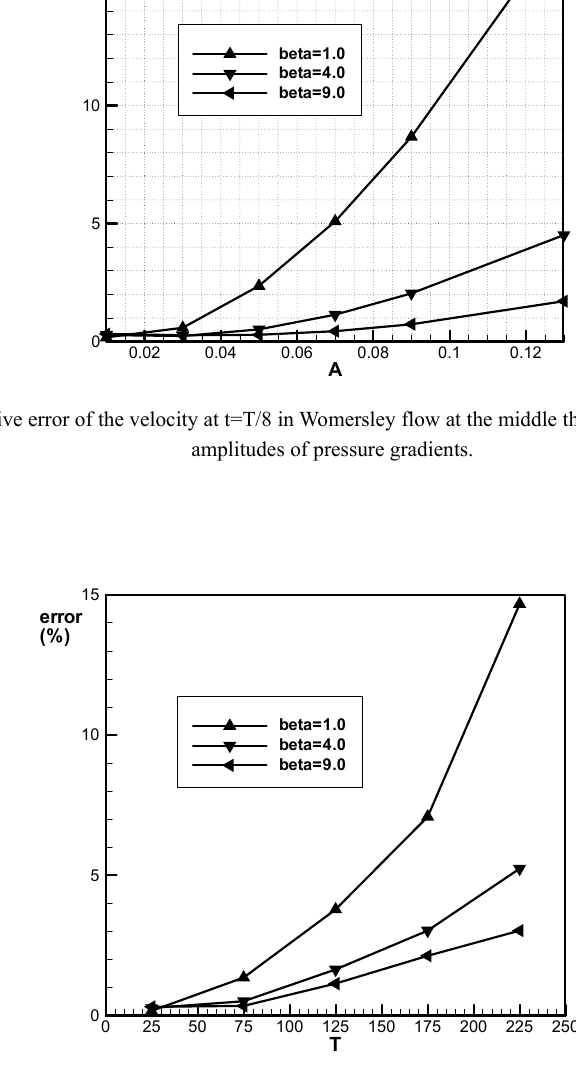
Fig.6 The relative error of the velocity at t=T/8 in Womersley flow at the middle of the channel against various periods of the driving